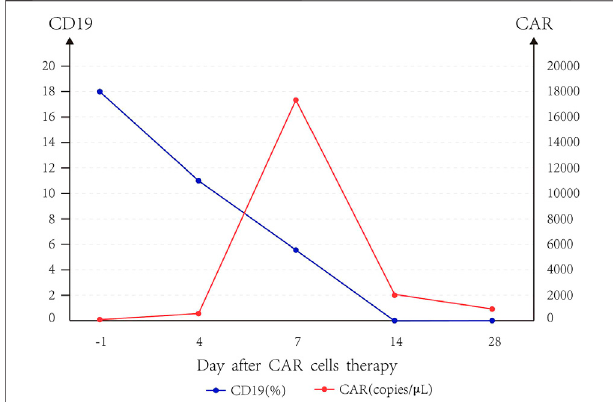
FIGURE 1 | Trend of CD19 and